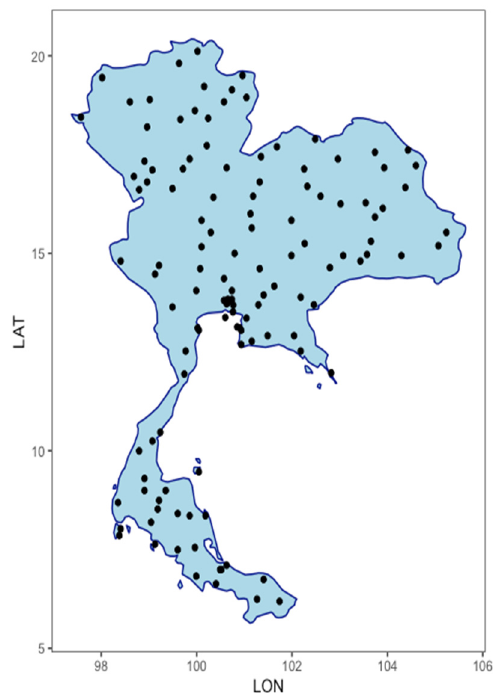
Figure 2. Spatial distribution of 124 meteorological stations in Thailand from the Thai Meteorological Department (TMD).